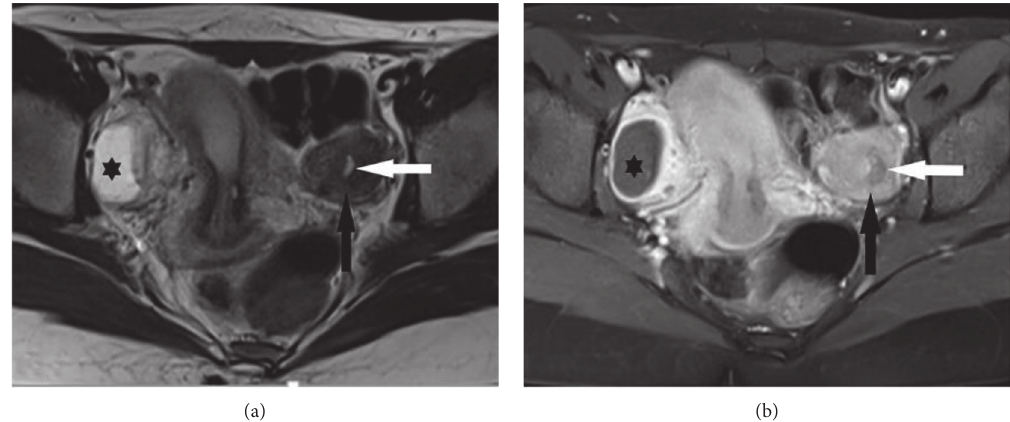
Figure 3: (a) Axial T2-weighted image of the pelvis shows a well-defined left-sided adnexal mass with signal intensity similar to the uterus (black arrow) with a central hypersignal endometrium (white arrow). (b) Axial contrast-enhanced fat-saturated T1-weighted image of the pelvis also demonstrates an enhancement similar to the uterus (black arrow). A right-sided simple ovarian cyst is also observed (asterisk). No pelvic lymphadenopathy is evident on magnetic resonance imaging.